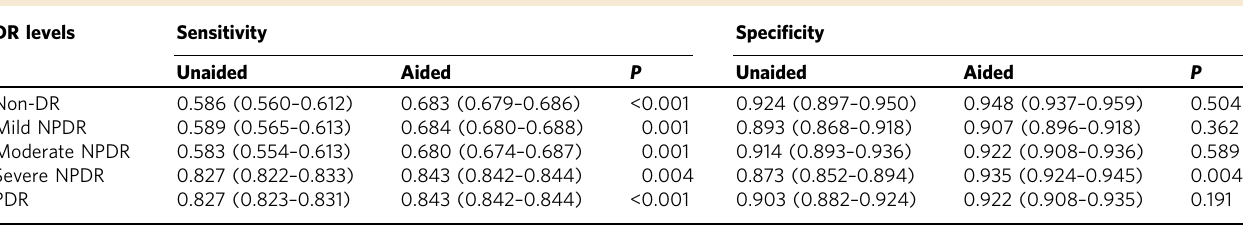
Table 2 The sensitivity and speci fi city for DR grading by primary healthcare workers with or without the help of lesion detection and